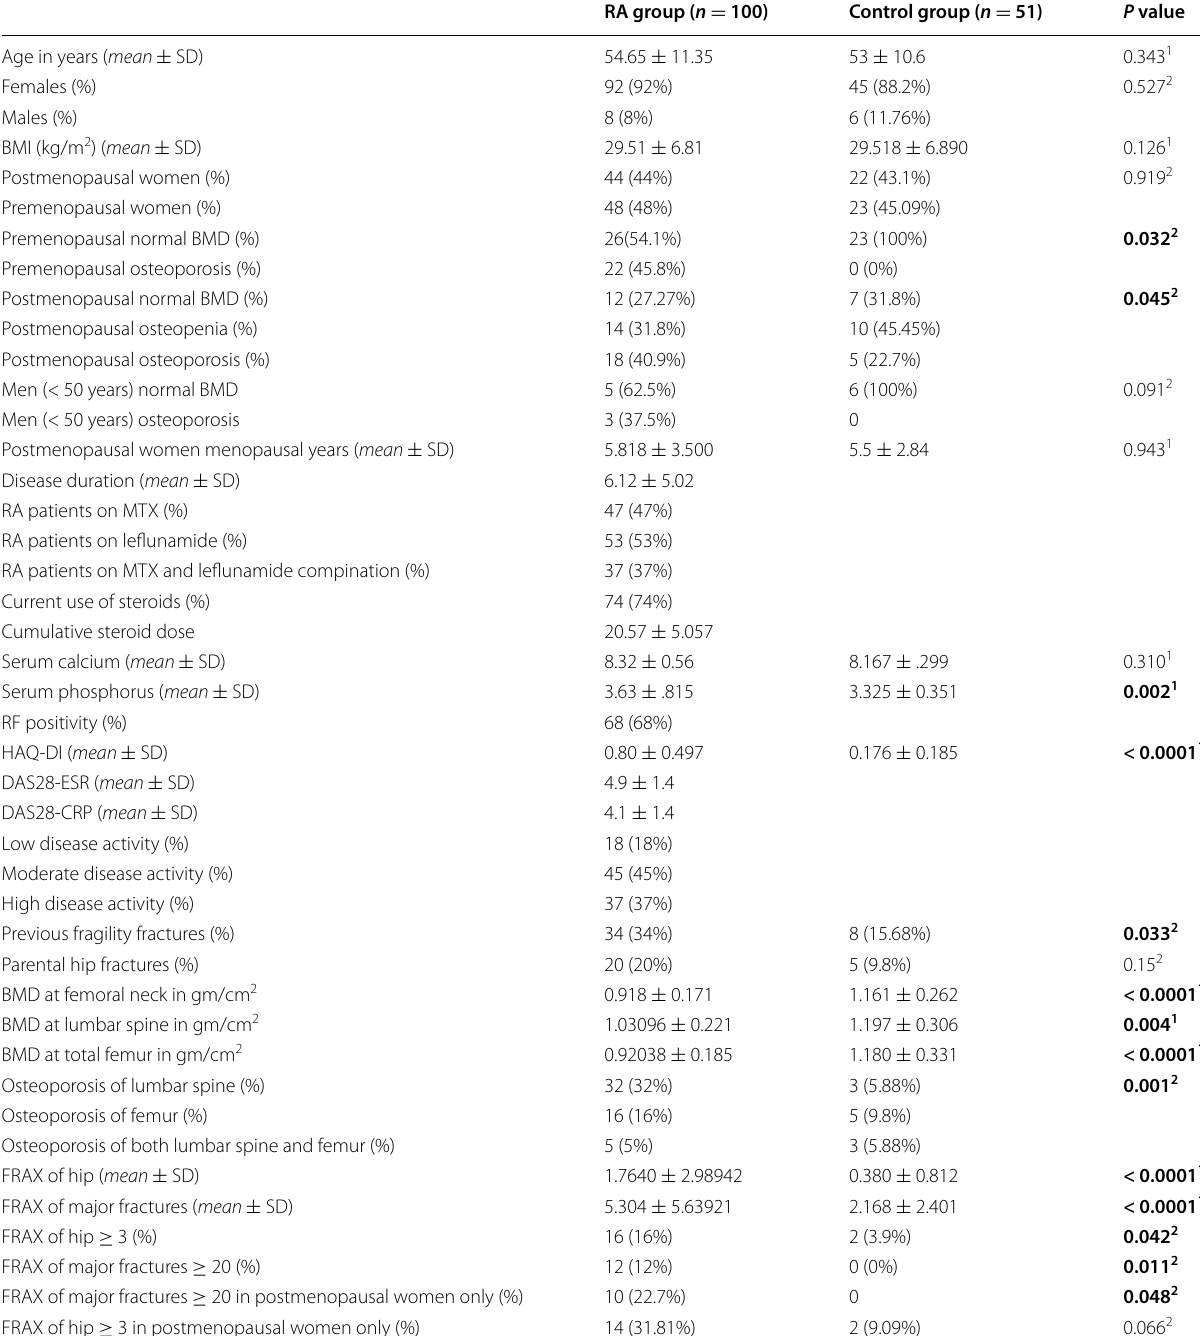
Table 1 Clinical and demographic characteristics in both